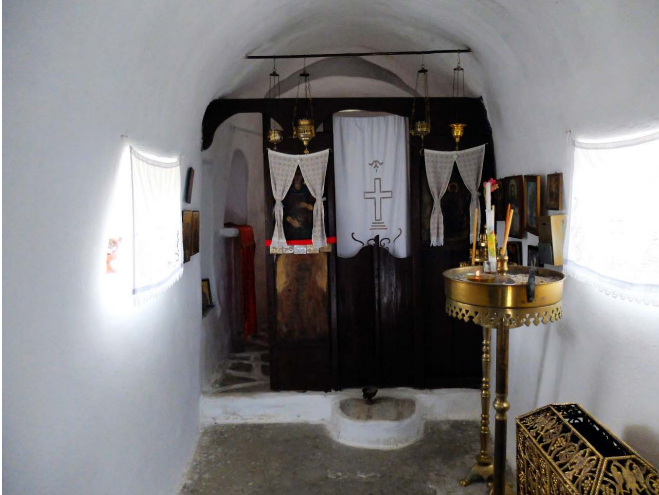
Figure 1. Interior of Greek Orthodox chapel, Naxos, Greece, Spring 2016 (Photograph by Jim Aulich).